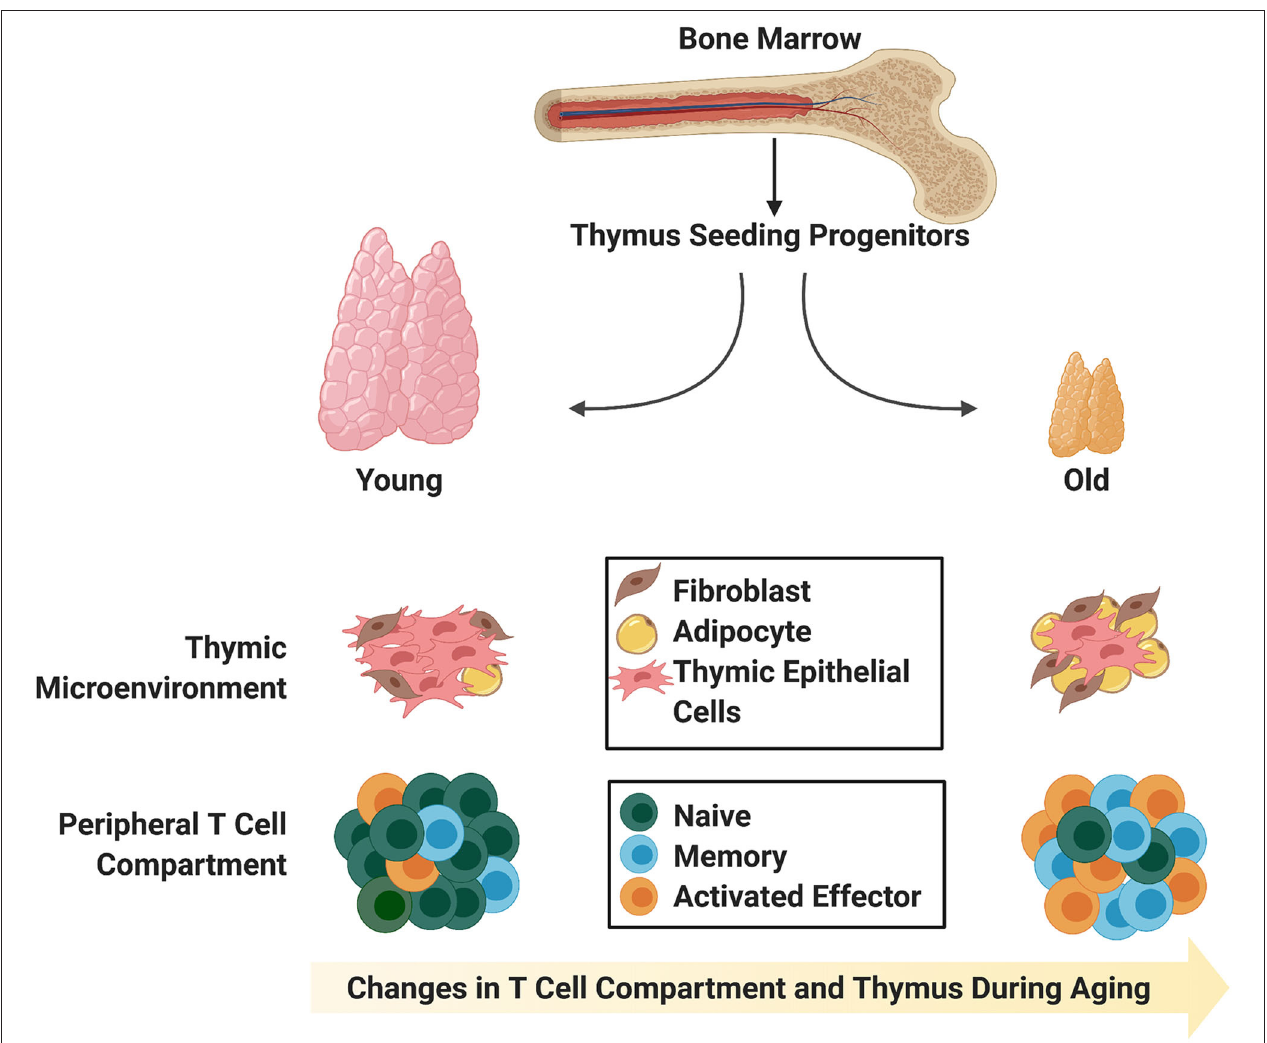
FIGURE 1 | Age-associated changes in the thymic stromal and T cell compartments. The young thymus is mainly comprised of thymic epithelial cells (medullary and cortical; not distinguished) capable of supporting rigorous thymopoiesis of naïve T cells with T cell receptor diversity. Naïve T cells comprise the largest proportion of peripheral T cells in young individuals. In contrast, the involuted aged thymus contains adipocytic and fibrotic cells, and the reduction in thymic epithelial cells and physical changes in thymic morphology do not support robust generation of naïve T cells with T cell receptor diversity. Instead, there is an enlargement in the peripheral memory T cell compartment, which is capable of giving rise to effector T cells upon